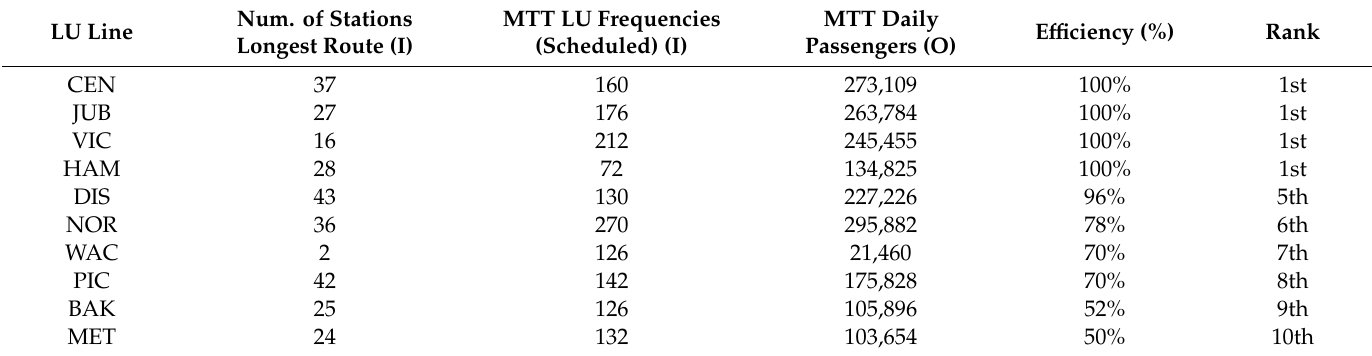
Table 13. URT lines DEA model scores of LU Monday to Thursday (MTT) PM peak tra ffi